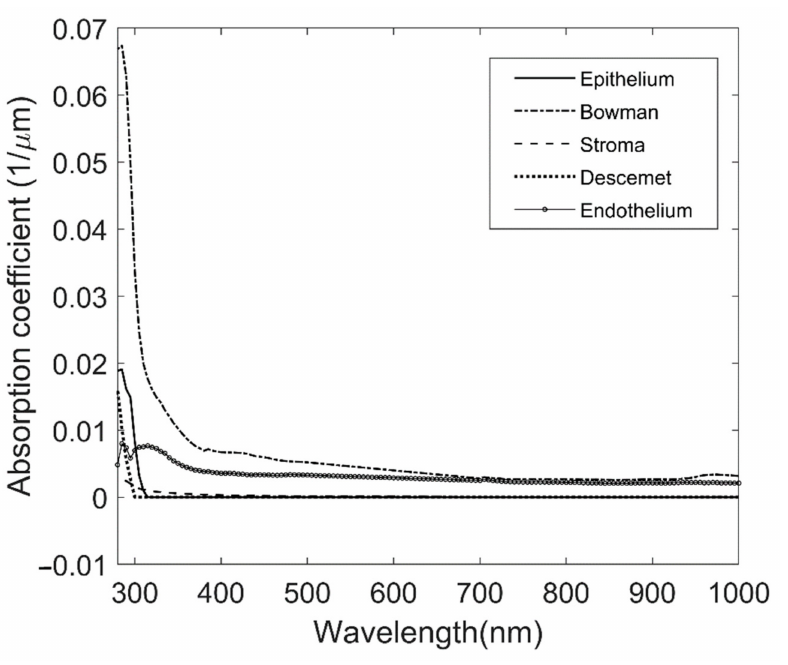
Figure 2. Absorption coefficient for the five corneal layers for all the measured ranges.